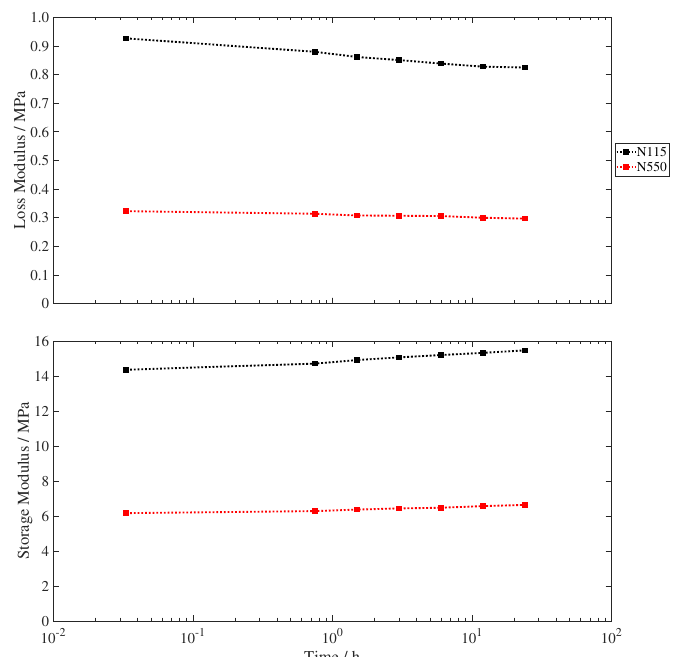
Figure A2. Evolution of the loss (top) and storage (bottom) modulus from 2 min to 48 h after a temperature drop from 70 to 20 ◦ C. The different carbon black types are plotted in black (N115) and red